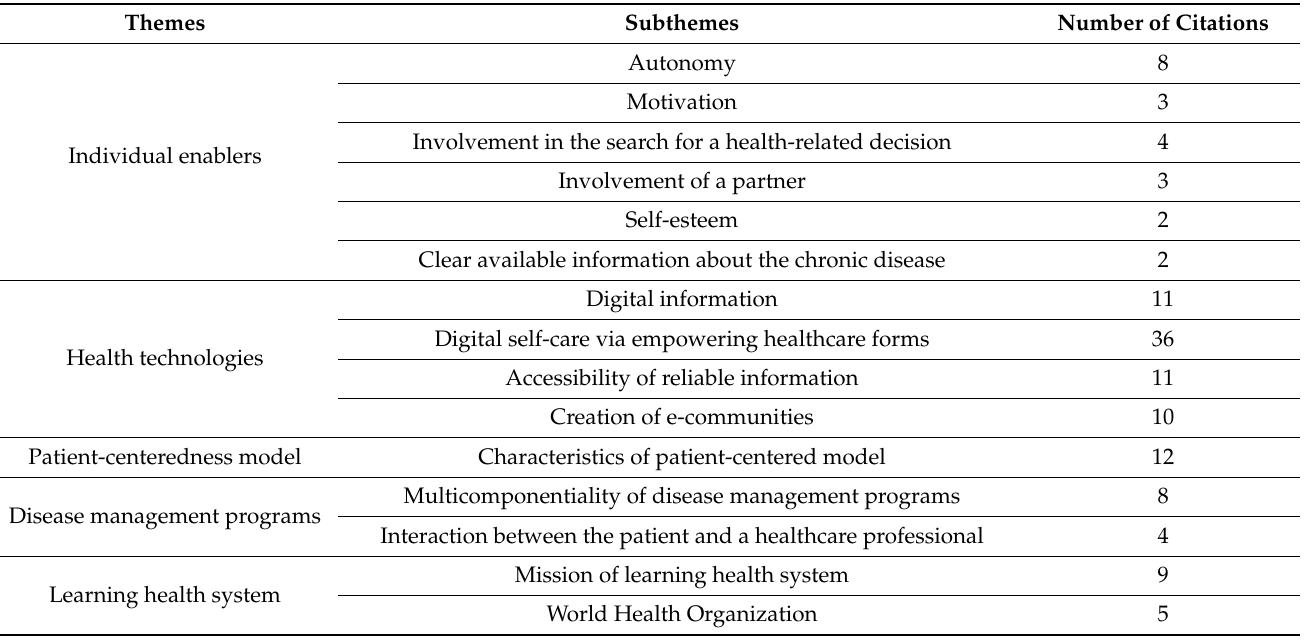
Table 2. Synthesis of identified themes in public health management literature (source: own elaboration).